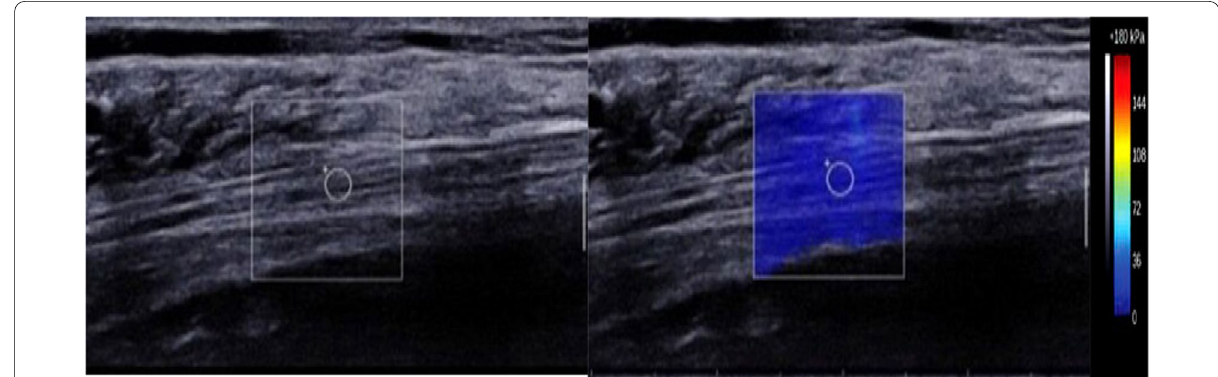
Fig. 5 A 51 years old male patient with DM without clinical evidence of DPN (Left) high resolution ultrasound showed normal tibial nerve CSA ( 10.6 mm 2 ). (Right) shear-wave elastography displayed mean tibial nerve stiffness value =